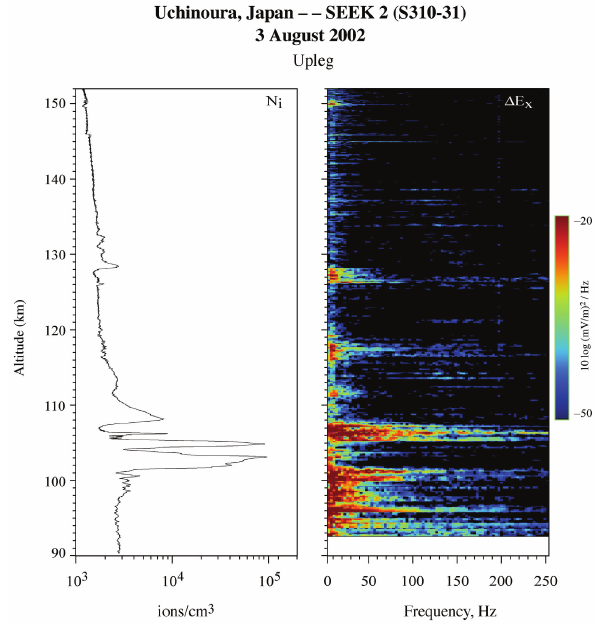
Fig. 4. Spectrograms of one component ( E x ) of electric fields from the electric field detector (EFD) (right panel) and plasma-density profile from FBP (left panel) (Pfaff et al.,